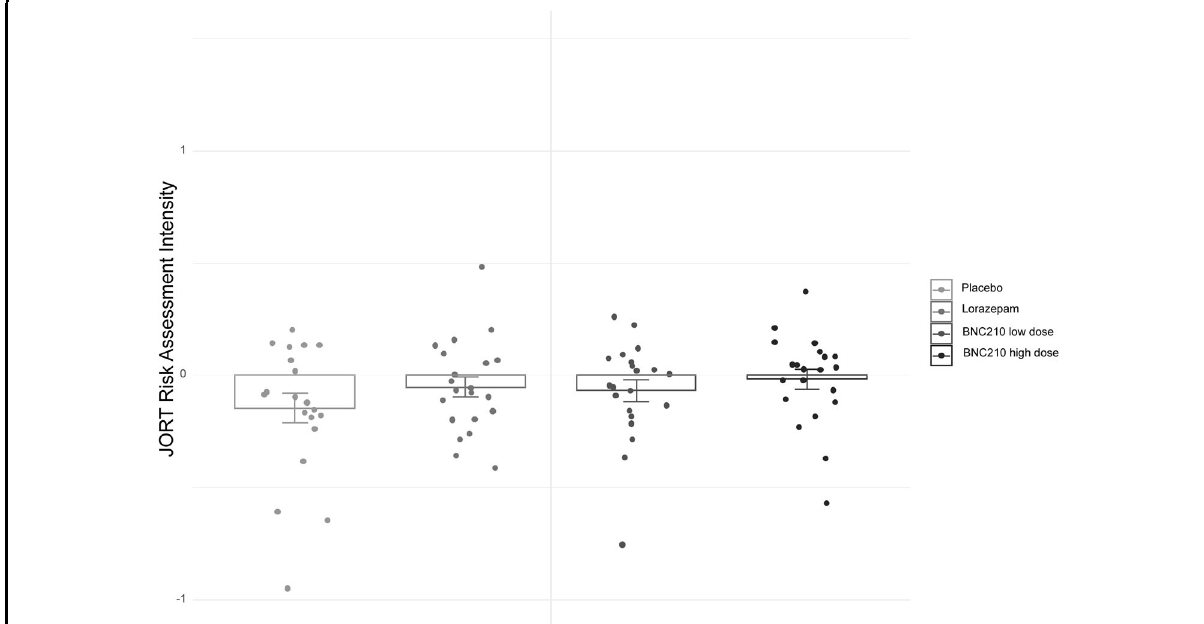
Fig. 5 Drug effects on Risk Assessment Intensity as measured by the Joystick Operated Runway Task (JORT). Risk Assessment Intensity was not signi fi cantly altered by BNC210 or lorazepam ( n = 21, error bars = 1